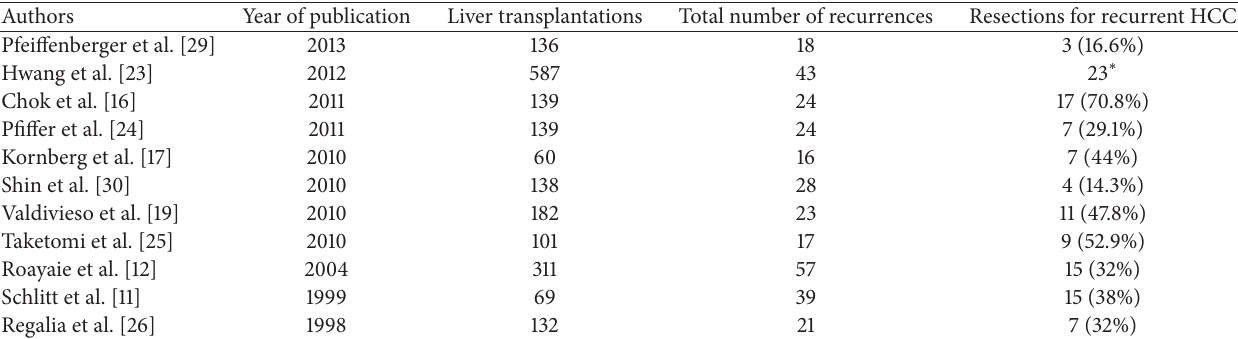
Table 1: Recurrence and resection rates following liver